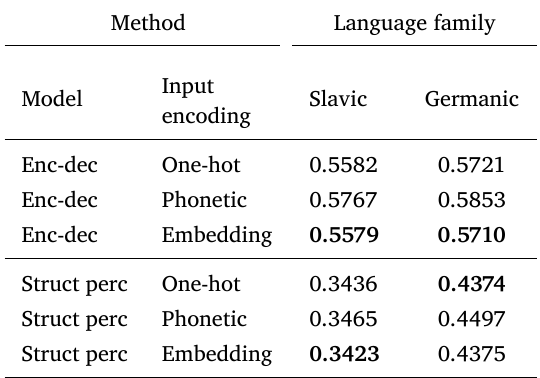
Table 4: Evaluation of different data encodings, on two models, by word prediction distance (edit distance between prediction and target) for two language families: Slavic and Germanic. The distance is the mean of the distance of all language pairs in the family. Lower distance means better